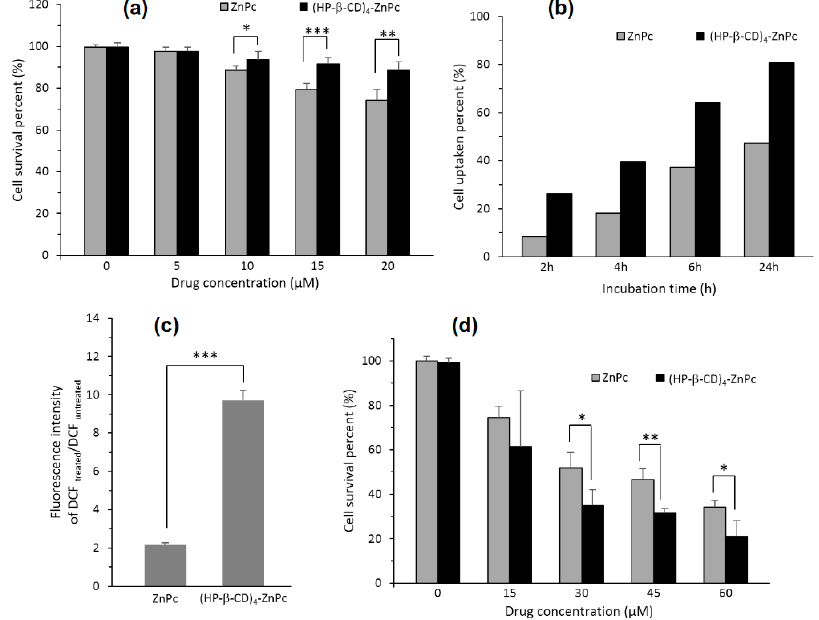
Figure 9. ( a ) Dark toxicity of zinc phthalocyanine (ZnPc) and (HP- β -CD) 4 -ZnPc (drug concentration was calculated by ZnPc. * p < 0.05, ** p < 0.01, *** p < 0.001 ZnPc vs. (HP- β -CD) 4 -ZnPc). ( b ) Human cervical carcinoma (HeLa) cellular uptake of ZnPc and (HP- β -CD) 4 -ZnPc ([ZnPc] = [(HP- β -CD) 4 -ZnPc] = 5 µM). ( c ) In vitro ROS production induced by ZnPc and (HP- β -CD) 4 -ZnPc ([ZnPc] = [(HP- β -CD) 4 -ZnPc] = 5 µM, irradiation time = 5 min, *** p < 0.001 ZnPc vs. (HP- β -CD) 4 -ZnPc). ( d ) Light toxicity of ZnPc and (HP- β -CD) 4 -ZnPc with different drug doses and 5 min irradiation (* p < 0.05, ** p < 0.01, ZnPc vs. (HP- β -CD) 4 -ZnPc). Adapted from Lu; Ma; Xuan; Wang; Zhao; Li; Zhou; Lin; Zhou; Wei [124].